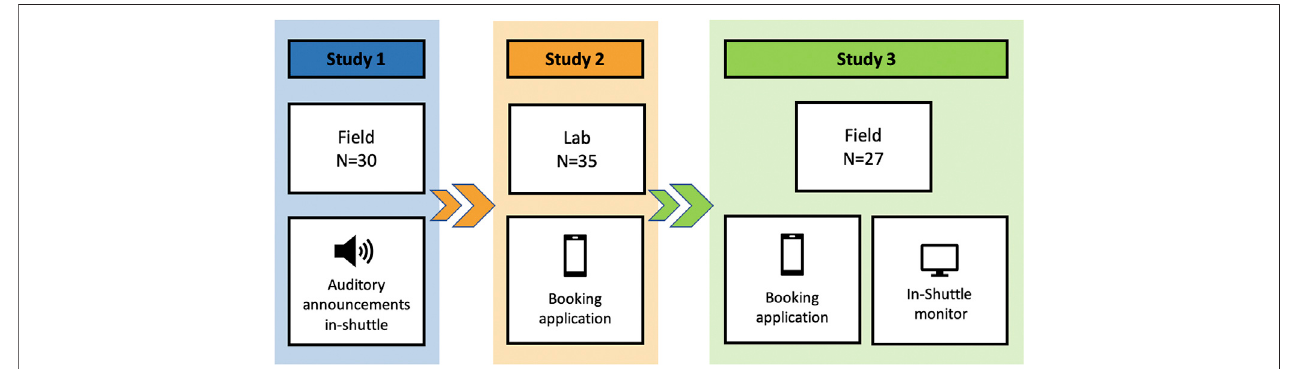
FIGURE 2 | Study 1: Shuttle over capacity — one group of passengers tried to see whether the shuttle would depart when one was standing.